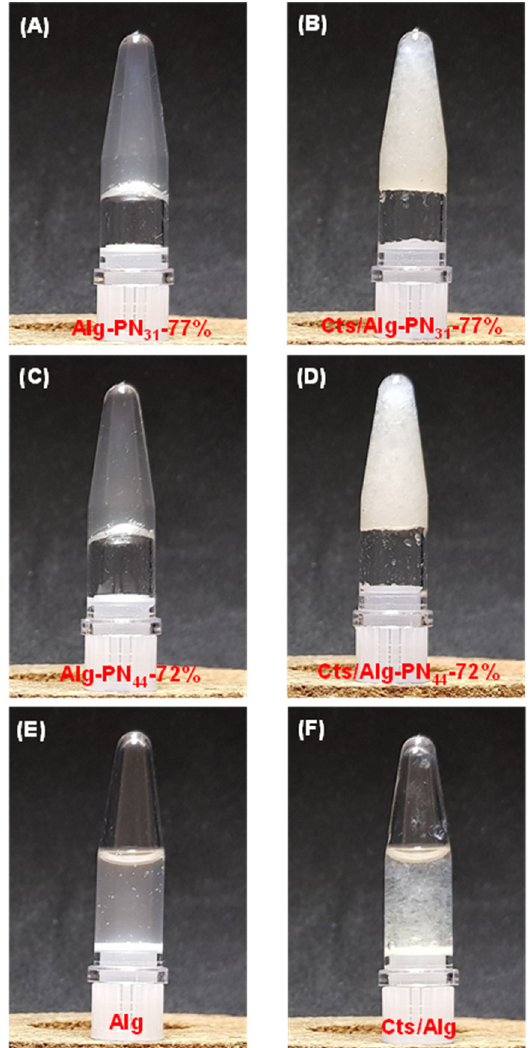
Figure 2. Photographs of copolymer hydrogels and PEC hydrogels formed at room temperature: